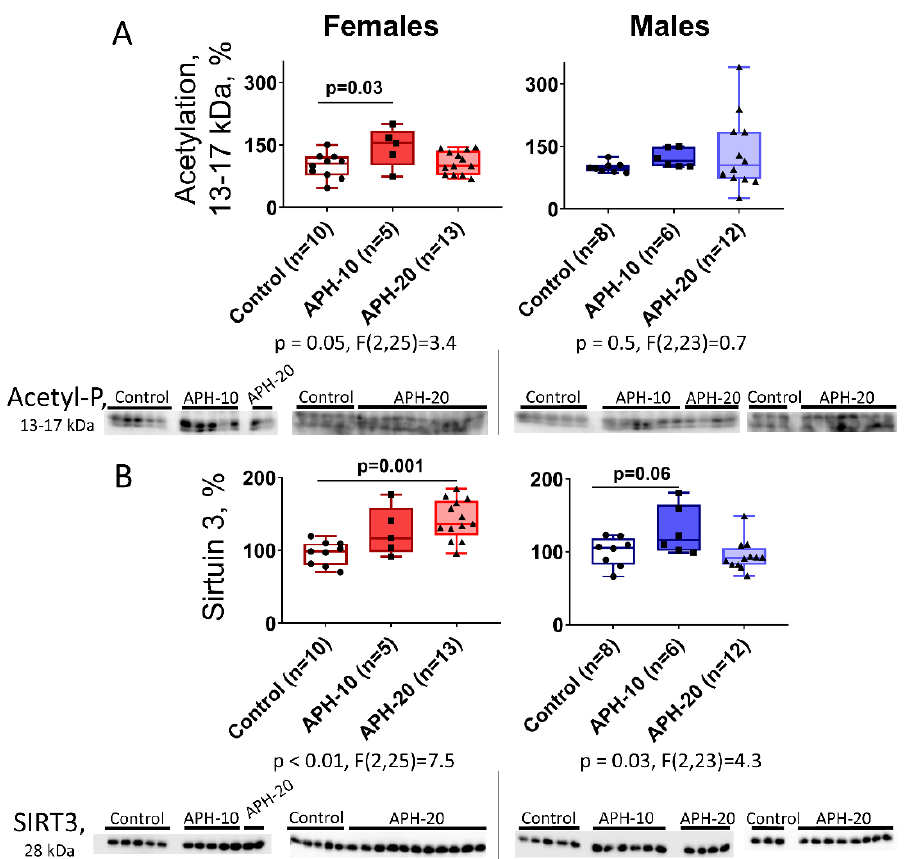
Figure 3. Influence of acute prenatal hypoxia at different gestational age on the levels of acetylation of low molecular mass proteins (acetyl-P) ( A ) and expression of sirtuin 3 (SIRT3) ( B ) in the brain of the APH-exposed female and male offspring. The p -values and F-statistics of one-way ANOVA are shown below the graphs. The results of the Tukey ’s post hoc test are indicated on the graphs. The presented Western blots cover all rats of the analyzed sample. n — the number of rats in each group.